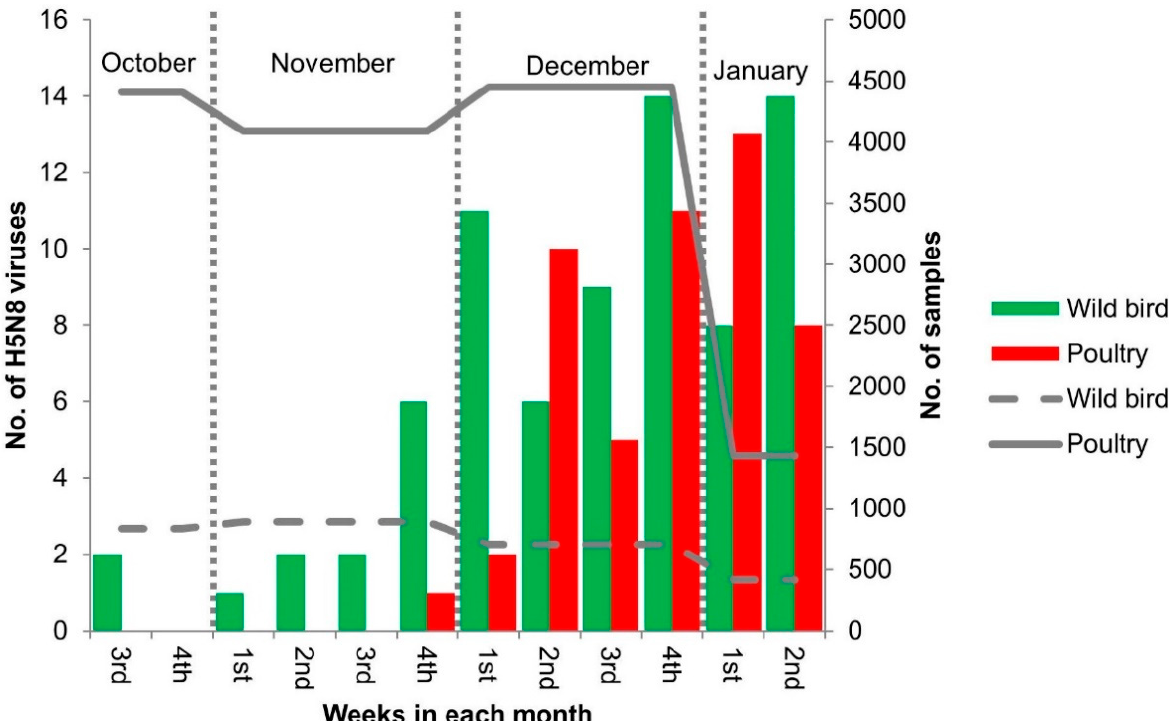
Figure 1. H5N8 highly pathogenic avian influenza viruses isolated from wild birds and poultry in South Korea during the winter of 2020–2021. Bars represent the numbers of H5N8 virus isolates in wild bird and poultry in South Korea according to time from October 2020 to January 2021 (green, wild bird; red, poultry). Lines represent the numbers of sampled wild birds and poultry (dotted line, wild bird; solid line, poultry).